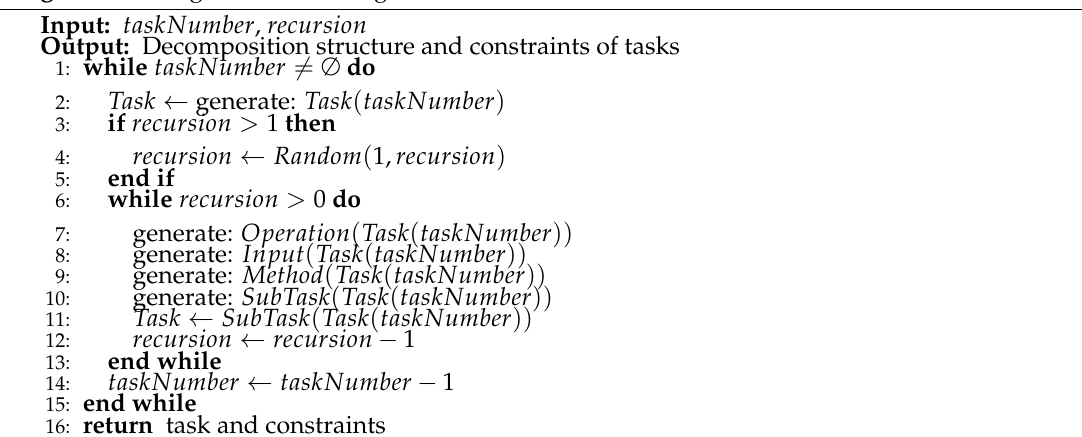
Algorithm 3: Algorithm for task generation for